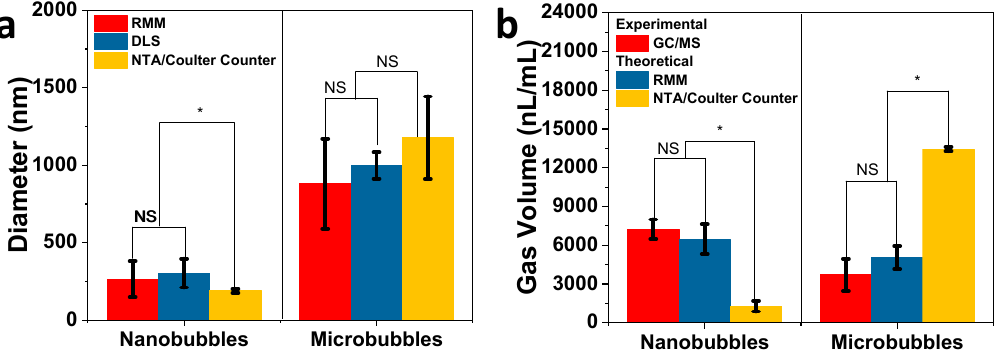
Figure 2. ( a ) Mean bubble size determined using resonant mass measurement (RMM), dynamic light scattering (DLS), nanoparticle tracking analysis (NTA), and Coulter counter. ( b ) Comparison of C 3 F 8 gas volume determined experimentally using headspace gas chromatography / mass spectrometry (GC / MS) and theoretically predicted based on RMM, NTA, and Coulter counter size and concentration measurements shown in ( a ) and Table 1, respectively. Statistical comparison of size and gas volume of nanobubbles and microbubbles were performed using one-way ANOVA ( p < 0.05). An asterisk * indicates that the difference of the means is statistically significantly different, while NS means they are not statistically significantly different. Table 1. Comparison of bubble concentrations measured using RMM, NTA, and Coulter counter. Sample